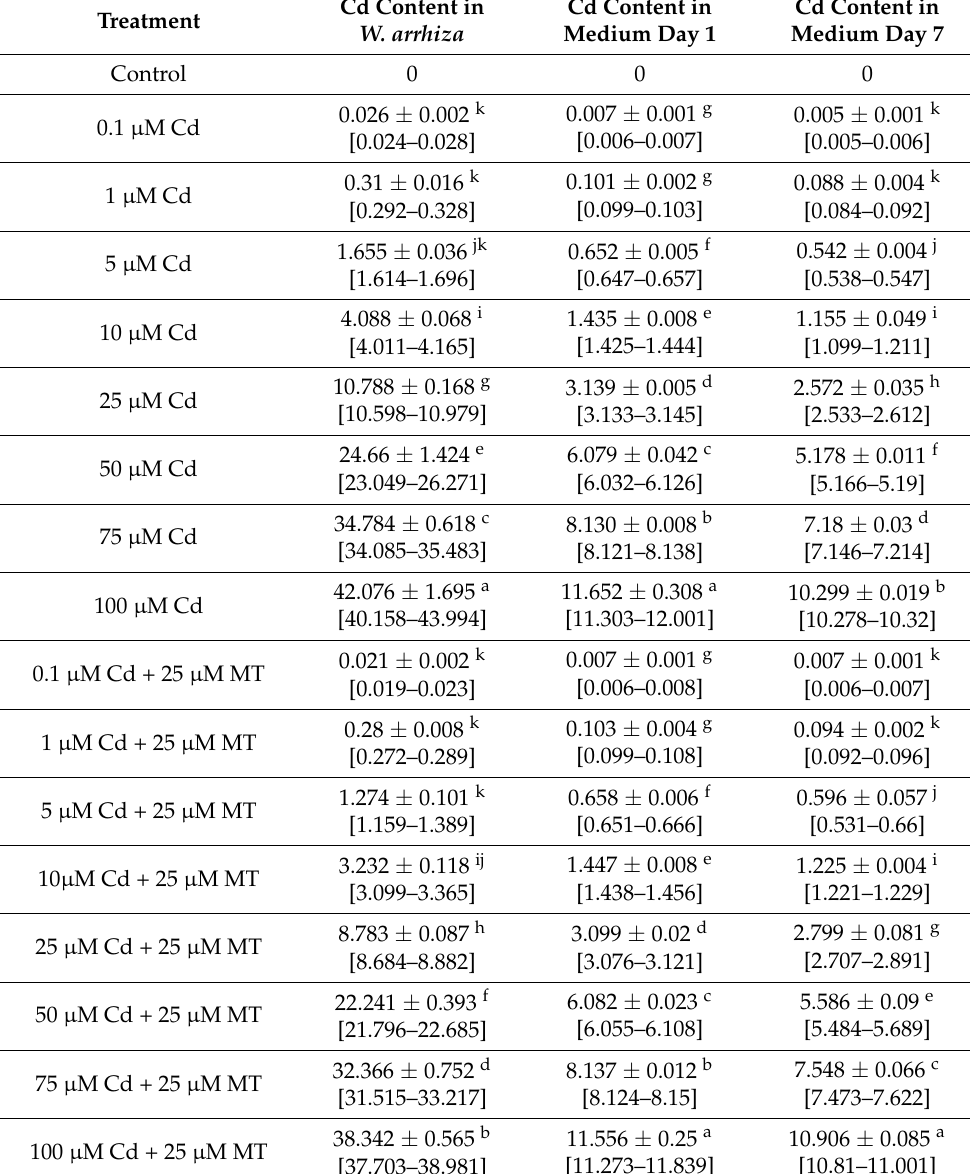
Table 1. Intracellular cadmium (Cd) content in W. arrhiza (mg/g dry weight) exposed to Cd or Cd with melatonin (MT) after 7 days of cultivation, followed by the content of Cd in medium (mg/L) on the 1st and 7th day of cultivation. The results present the mean ( n = 5, biological replicate) ± standard deviation. The range in square brackets corresponds to the 95% confidence interval of the means. Means with the same letters are not significantly different ( p ≥ 0.05) according to Tukey’s post hoc